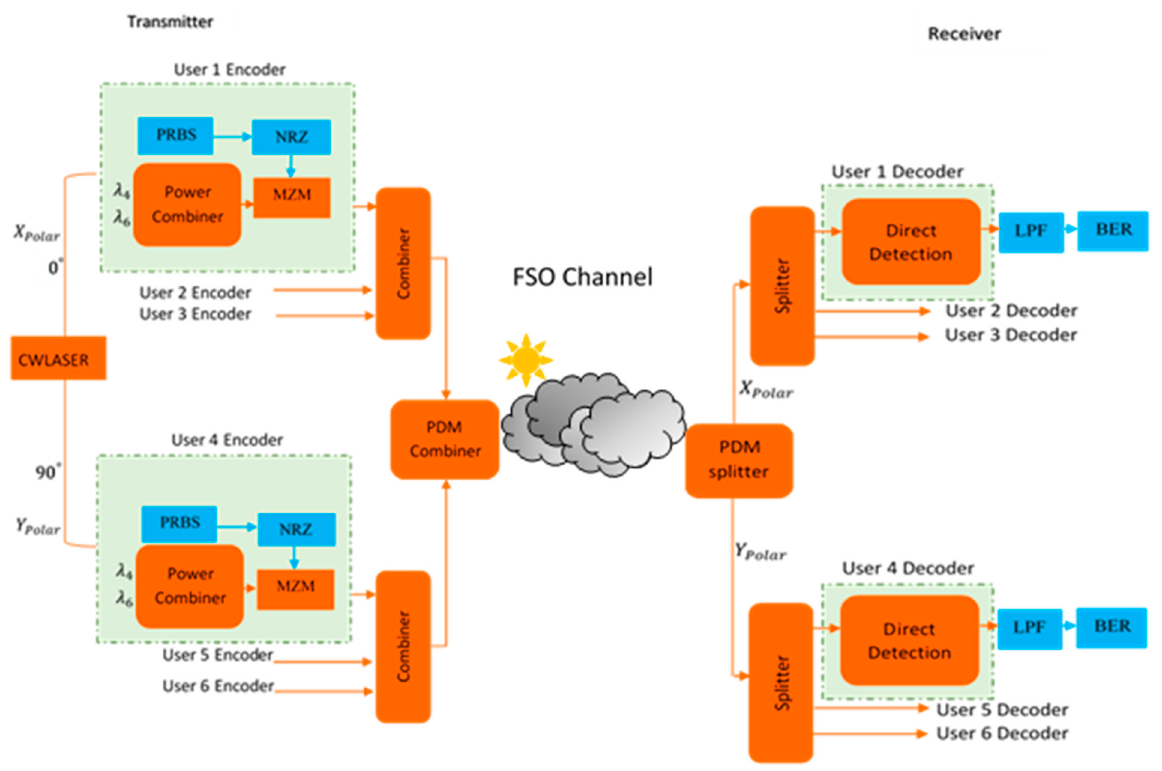
Figure 2. Setup of PDM-SAC-OCDMA-enabled FSO system. Table 3. Users assigned with ZCC code and their corresponding wavelengths.